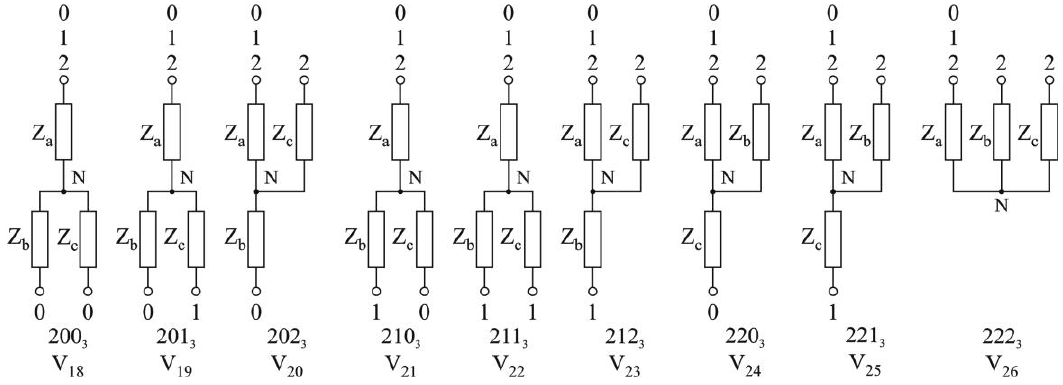
Figure 6. Possible connections of the load to terminals 0, 1, 2. Potentials of terminals 0, 1, 2 are equal, respectively: 0 , U D / 2 , U D .